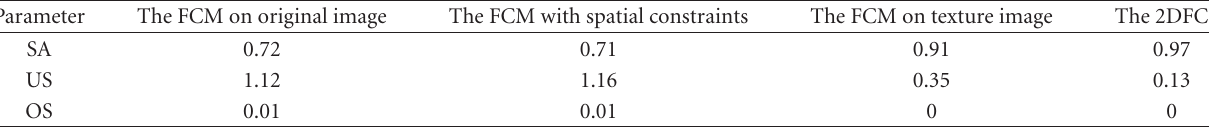
Table 1: SA, US, and OS of the three-conventional FCM and 2DFCM on Figure 3.